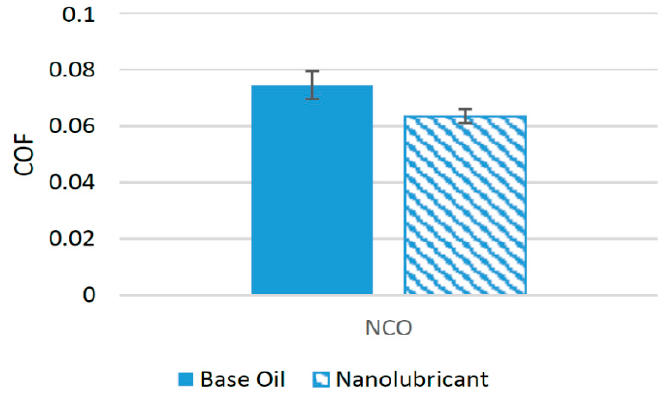
Figure 15. Effect of ZnO NPs on the friction performance of bio-lubricants.